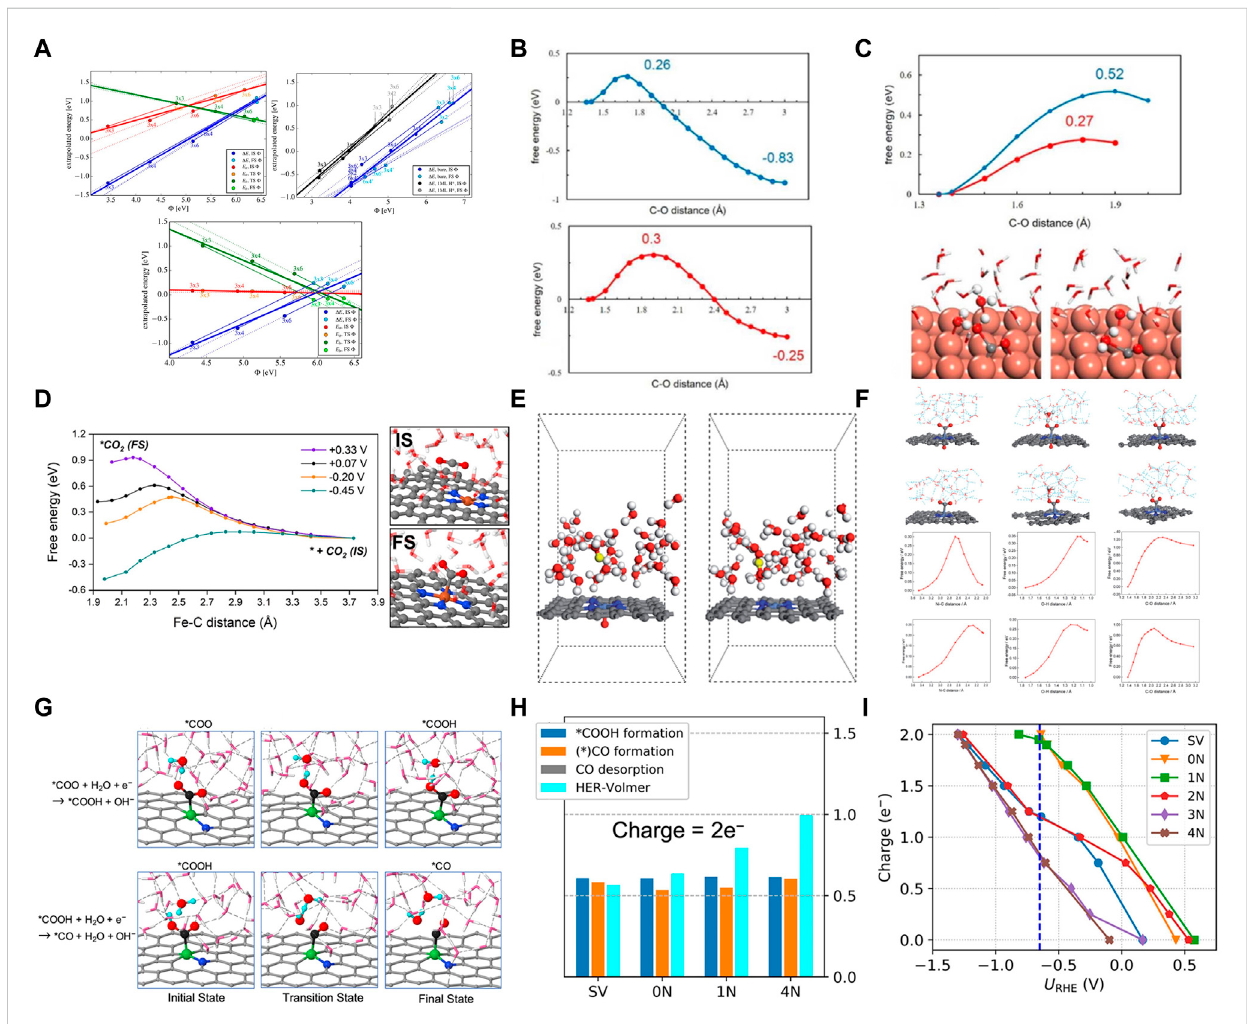
FIGURE 9 (A) Each constant charge barrier/reaction energy is represented by thin solid lines; thin dotted lines stand for beyond these energies. (Figure used with permission from Nørskov et al., 2016) (B) Free energy pro fi les for the C-O 1 (in blue) and C-O 2 bond breaking (in red). (C) Free energy pro fi les for the C-O 1 and C-O 2 bond breaking and key structures in the C-O 1 bond breaking. (Figure used with permission from Sun et al., 2012) (D) Free energy pro fi les of CO 2 adsorption under different potential energy potentials at Fe-N 4 -C/water interface. Reproduced with permission. ( fi gure used with permission from Wang et al., 2022) (E) Geometric con fi guration of NiN 4 – O/C and NiN 4 /C in an aqueous solution. Grey, C; blue, N; light blue, Ni; red, O; white, H; yellow, hydronium. (F) Snapshots and reaction energies of initial, transition and fi nal states for the *COOH formation on NiN 4 – O/C and NiN 4 /C by AIMD simulations. (Figure used with permission from Zhou et al., 2021) (G) Reaction evolution snapshots of *COOH and *CO formation on 1 N site. Colorcodes:Ni,Green;C,black;O,red;H,cyanspheres.Dashedlinesrepresenthydrogenbonds. (H) Charge=2e − and (I) Chargecapacityfor*COOHat different sites under the potentials. (Figure used with permission from Liu et al.,